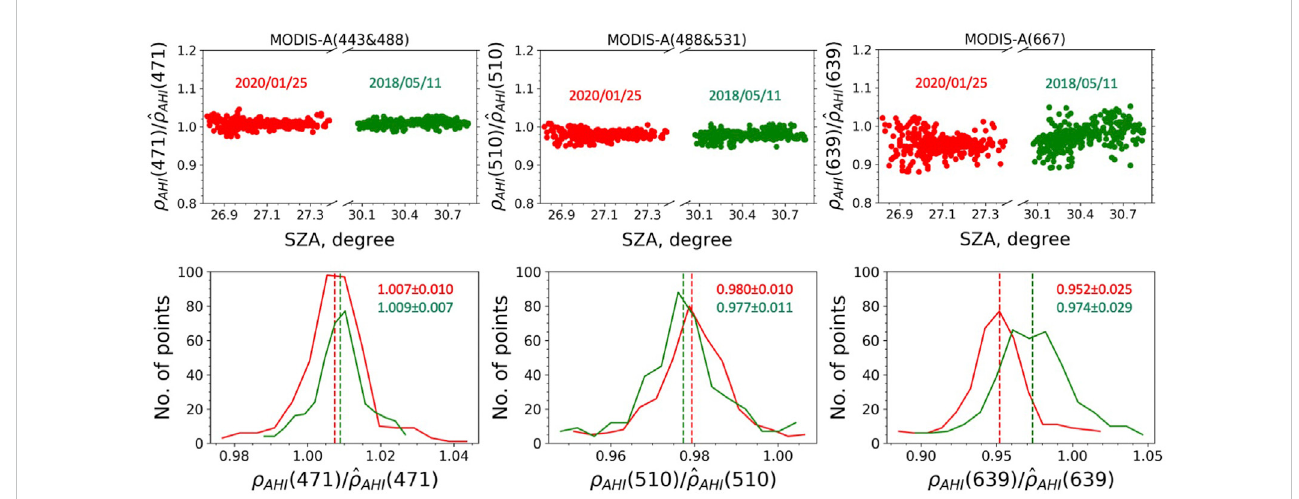
FIGURE 6 SameasFigure5,butfortheequivalentAHIre fl ectance ^ ρ AHI at471,510,and569 nmgeneratedusingMODIS-A443&488 nm,488&531 nm,and667 nm.